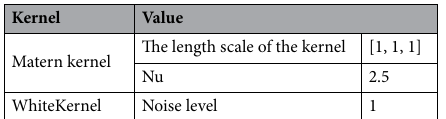
Table 5. The kernel function parameters of GP regression in BO.